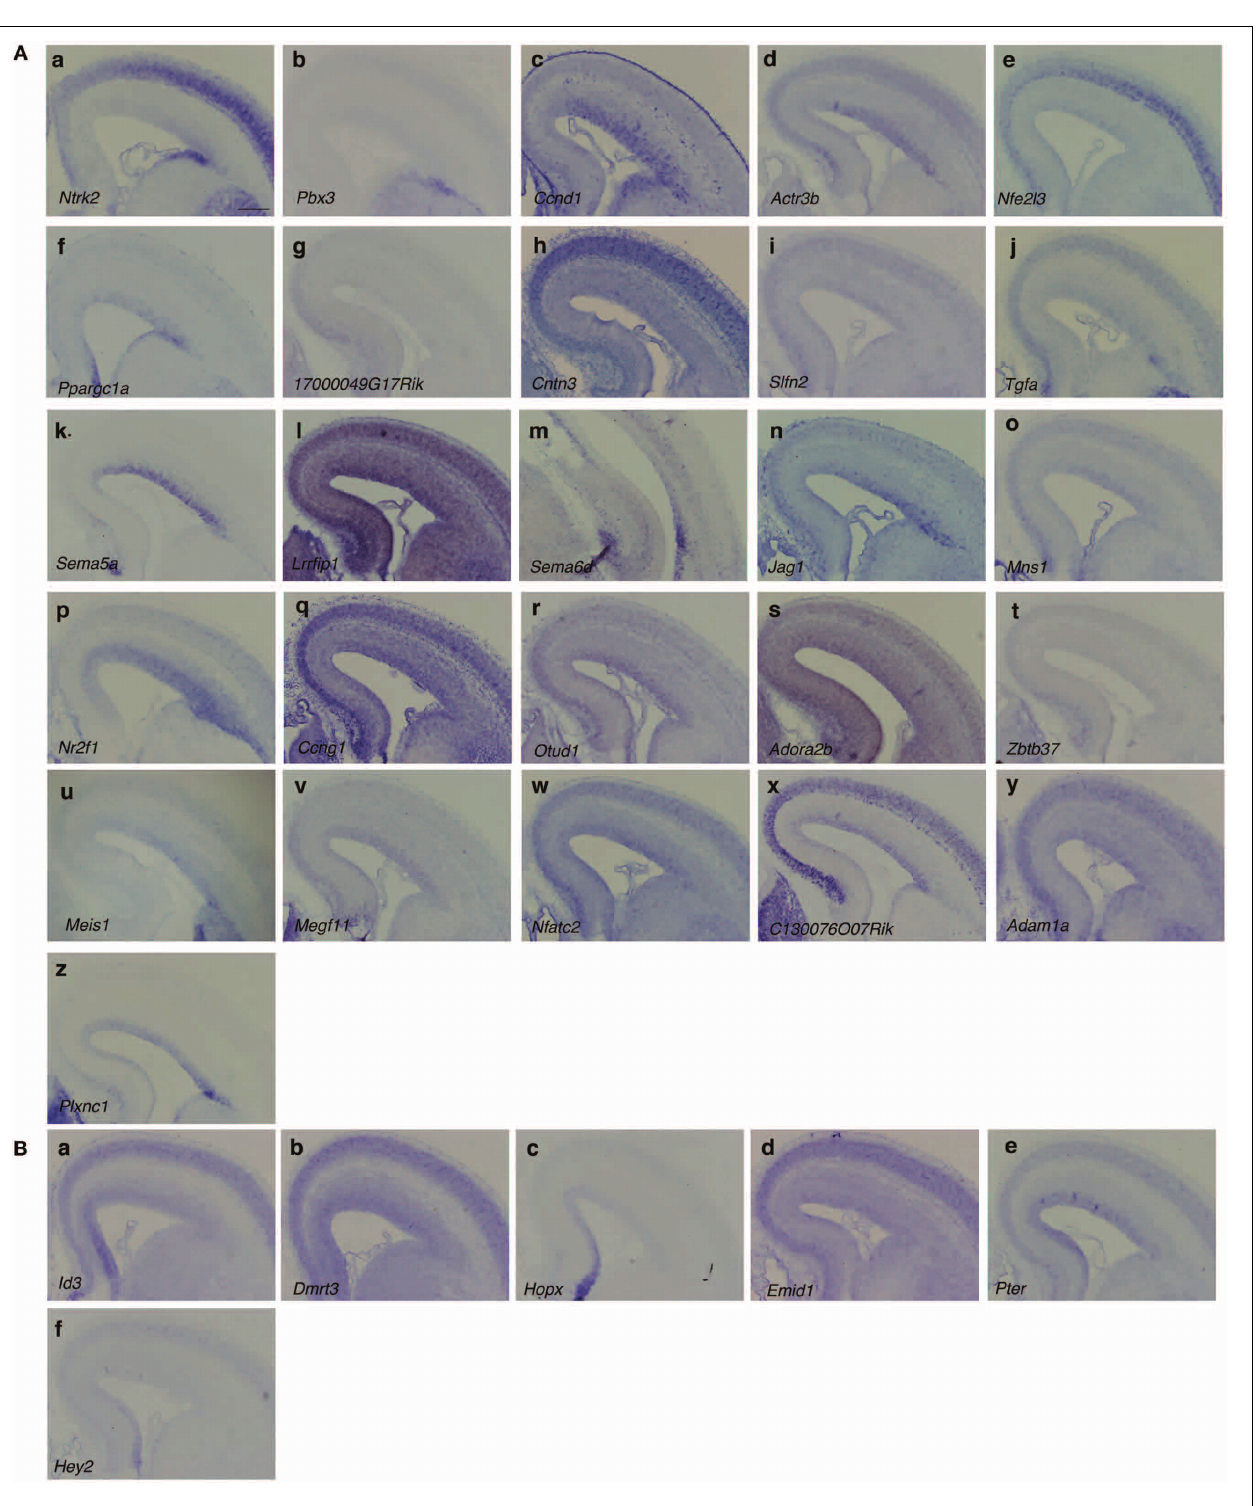
FIGURE 2 | In situ hybridization of candidate genes. The DIG-labeled RNA probes of the indicated genes were hybridized on the coronal section of E16 mouse brains. Genes with (A) lateral-high and (B) medial-high expression patterns are shown. Scale bar: 200 μ m.